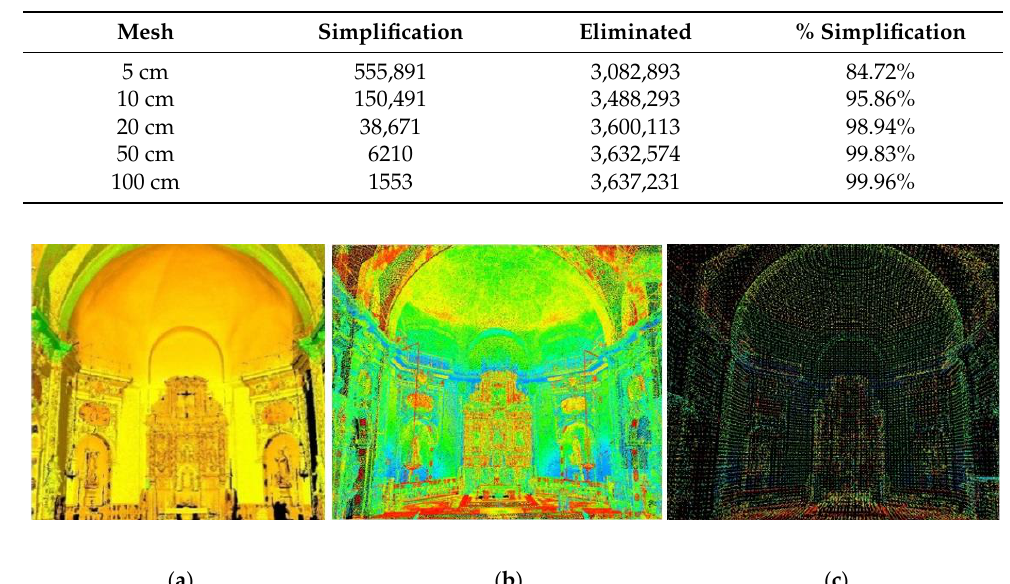
Table 1. Simplification of clouds.